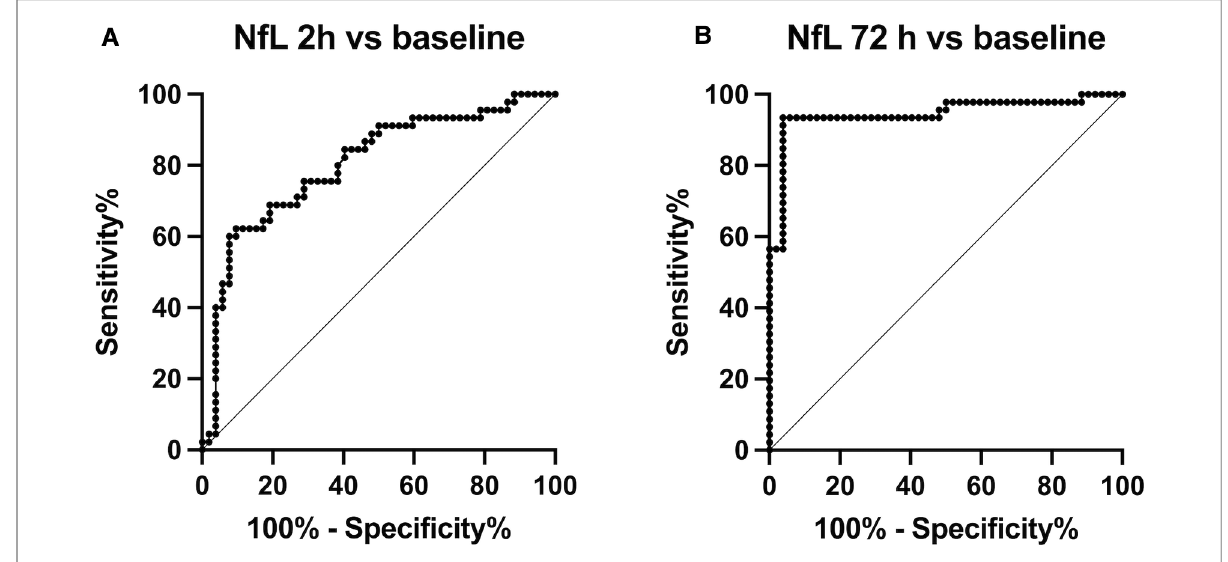
FIGURE 2 Receiver operating characteristic (ROC) curves, ( A ) comparing NfL-2 h with NfL-base and ( B ) NfL-72 h with